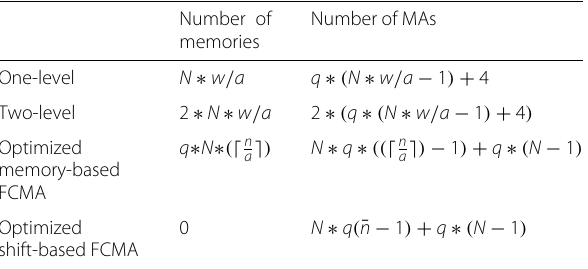
Table 3 Memory usage and adders for RNS-based